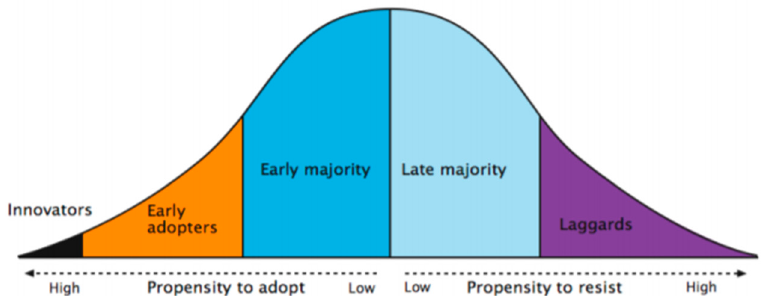
Figure A3. Rogers’ adoption categories in Diffusion of Innovation Theory. Adapted from the work by the authors of [20].